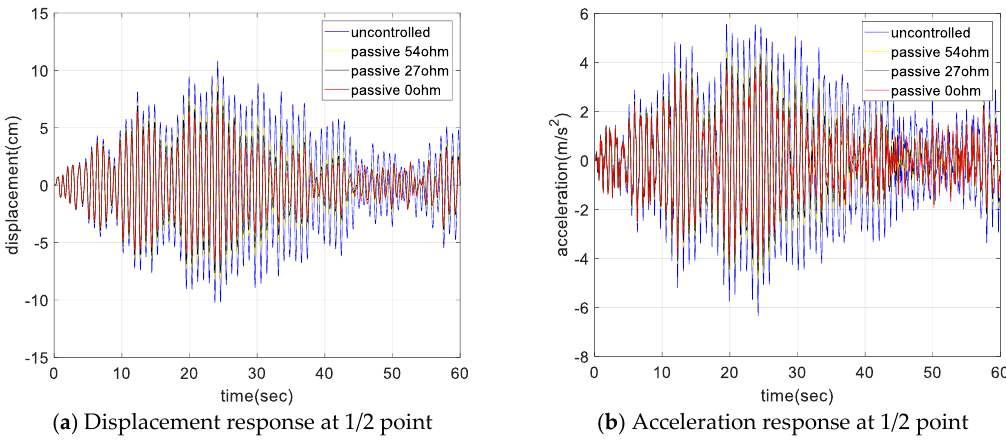
Figure 13. 5 m/s mean wind speed, 1/2 L response.